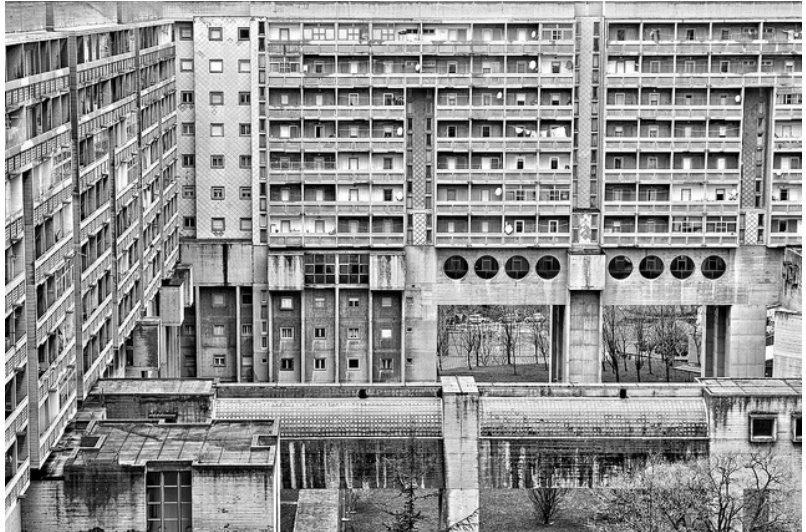
FIG. immagine/00010/6294OP1593AU10698.jpg]Rozzol Melara (Trieste) [Picture taken from: https://c1.staticflickr.com/3/2811/9 004643693_81063ac07e.jpg]